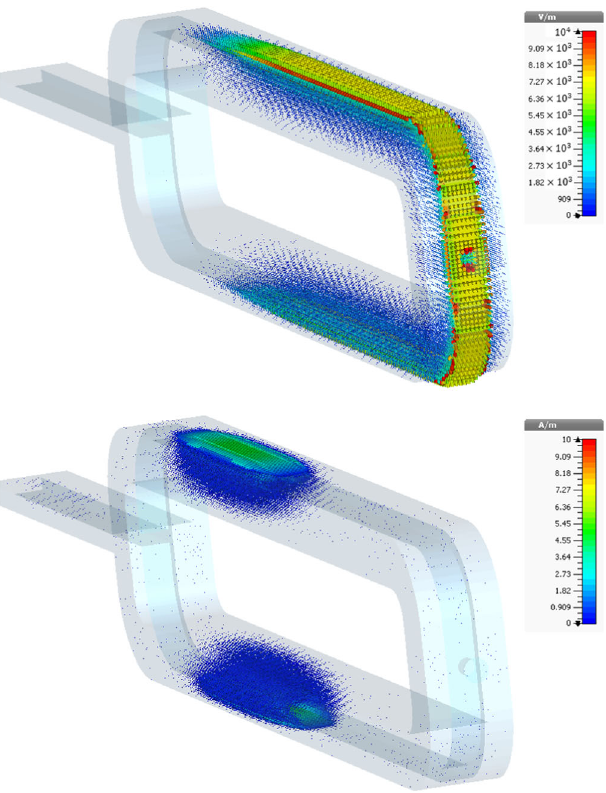
FIG. 5. The electric (top) and magnetic (bottom) field distri- butions in the stripline-loop at the moment when the middle of the pulse passes the cathode. The magnetic fields cancel each other. The simulation is performed with the CST microwave studio.